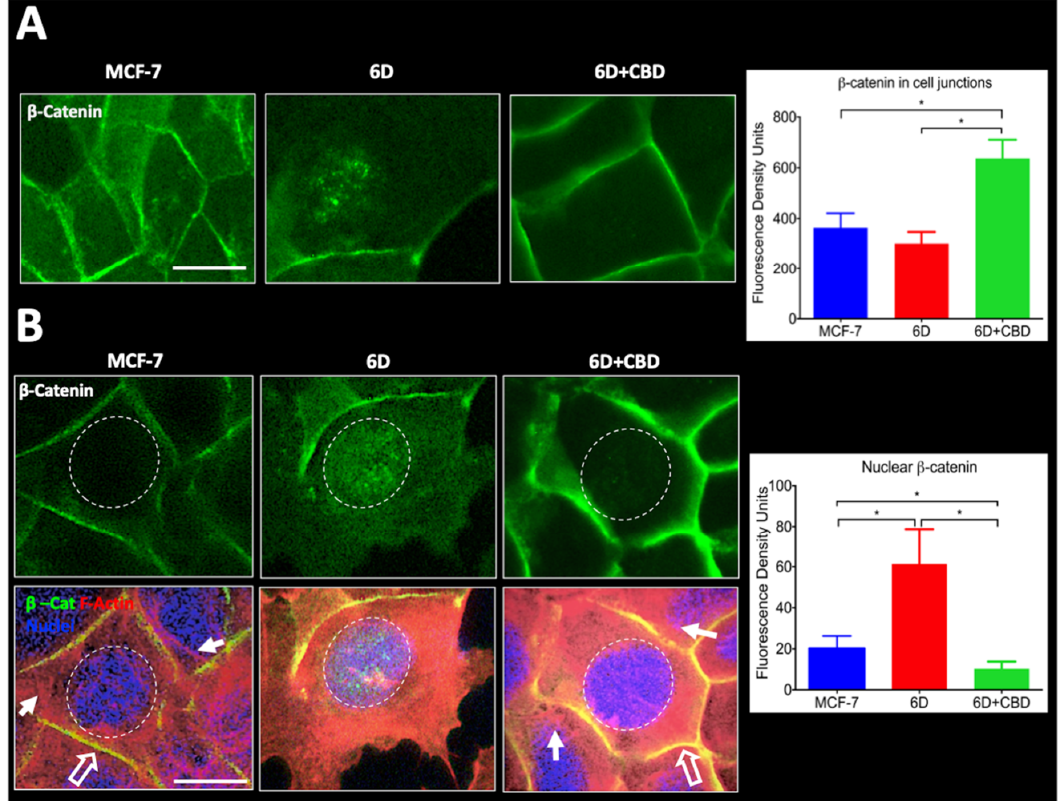
Figure 4. Quantification of β-catenin levels in cell junctions and nuclei. ( A ) The three panels in the figure show representative images taken from randomly selected fields to measure the fluorescence density levels of β-catenin in the cell junctions of MCF-7 and 6D cells treated or not treated with CBD. The graph on the right shows the fluorescence density units obtained. ( B ) Top panels show images of MCF-7 and 6D cells treated or not treated with CBD and stained with anti-β-catenin antibody to visualize and measure the protein in the nuclei. The graph on the right shows the fluorescence density values obtained. The bottom panels show cells stained with phalloidin to visualize actin fibers (red), nuclei (blue) and β-catenin (green). The graph on the bottom shows the obtained values of nuclear β-catenin levels. Fluorescence density units results represent the average of three independent batches of cells (biological replicates, n = 3) ± SD. Full arrows indicate actin fibers, empty arrows indicate colocalization of actin and β-catenin in the cell junctions (yellow). Asterisks indicate significance at p < 0.05. Bar = 20 µm.